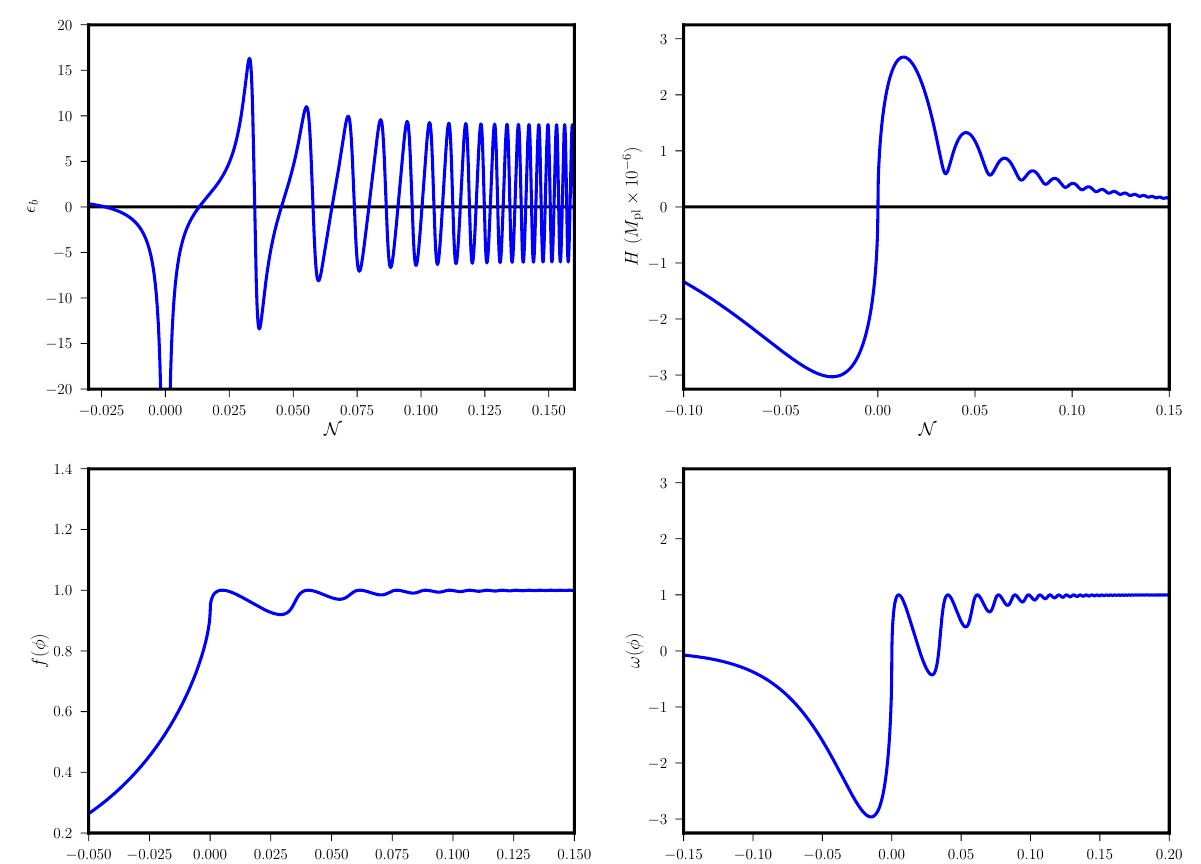
Figure 2. The slow-roll parameter (cid:101) b ( top-left ), Hubble parameter H b ( top-right ), the coupling function f ( φ ) ( bottom-left ) and ω ( φ ) ( bottom-right ) in the non-minimal theory (4) are plotted for the chaotic bouncing model with α = 2 with respect 2 to the e-N-fold time convention ( 2ln ( a / a 0 ) , for contraction, is negative, whereas, at bounce, it becomes zero N N ≡ N and then during expansion, it becomes positive) during and after the bounce. One can see that the bouncing solution is asymmetrical. The coupling function f ( φ ) as well as ω ( φ ) become nearly unity in the reheating epoch, which appears shortly after the